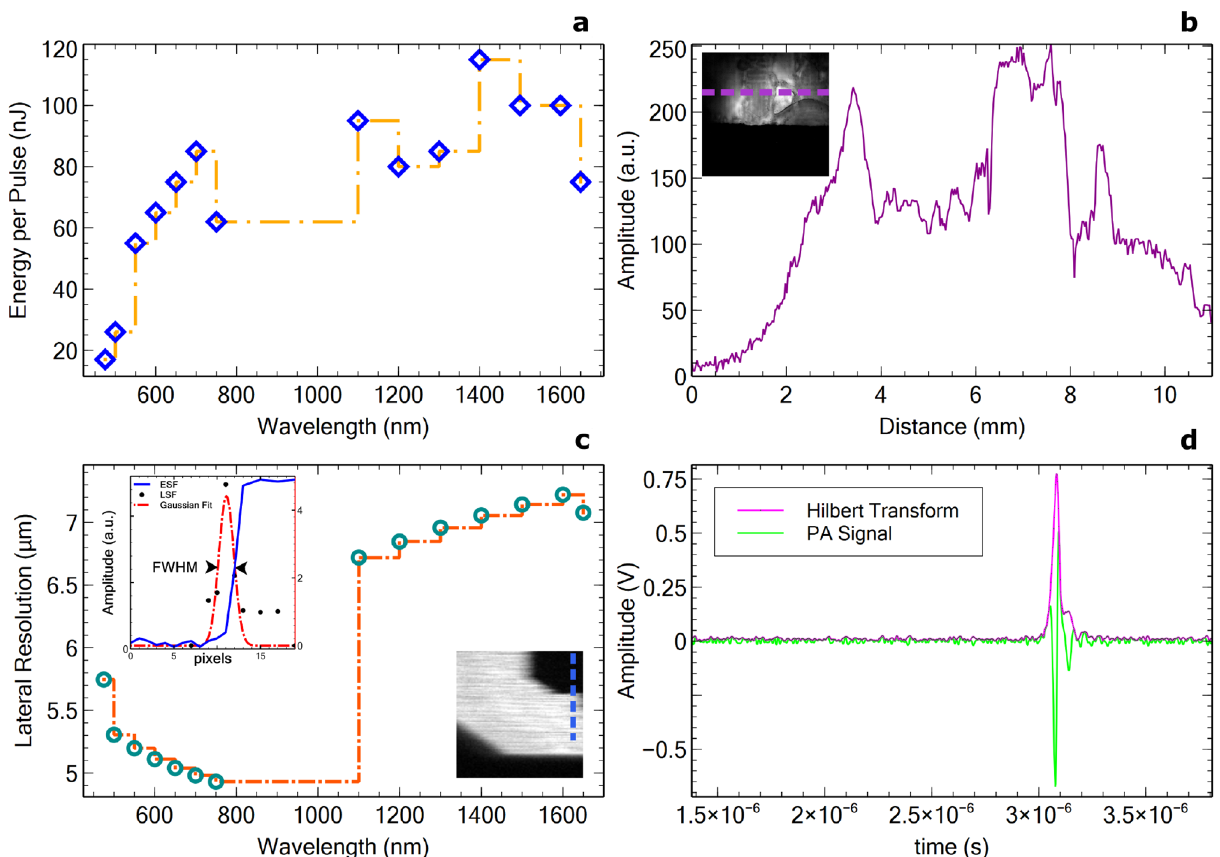
Figure 2. OS-PAM System characterization; ( a ) EPP graph over the whole imaging spectral range measured on the sample; ( b ) Characterisation of the lateral field of view (FOV) of the instrument. PAM signal collected whilst imaging a carbon fibre tape is plotted for each lateral position in the image. The plot corresponds to the amplitudes of the signal at the positions showed by the purple dashed line in the inset image. The size of the image 10 × 10 mm; ( c ) Lateral resolution per wavelength measured by imaging a sharp edge (letter) on a USAF target, extracting the ESF and calculating the LSF. The size of the image is 0.5 × 0.5 mm; ( d ) Axial resolution measured imaging carbon fibre tubes. The Axial resolution is defined by the FWHM of the Hilbert transform (Signal